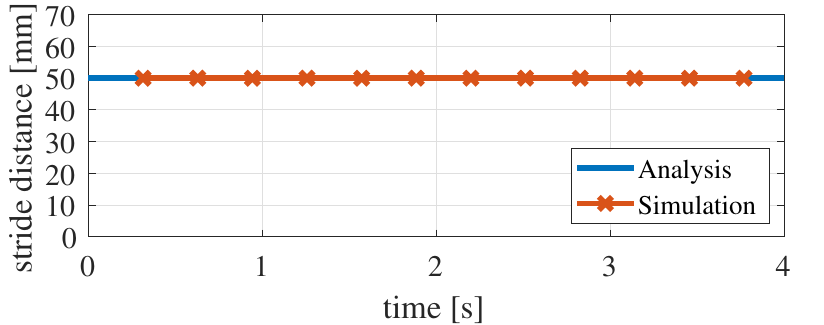
Figure 7. The time variation of the stride length in the simulation for forward locomotion. The simulation results show that the robot walks with a constant stride length.